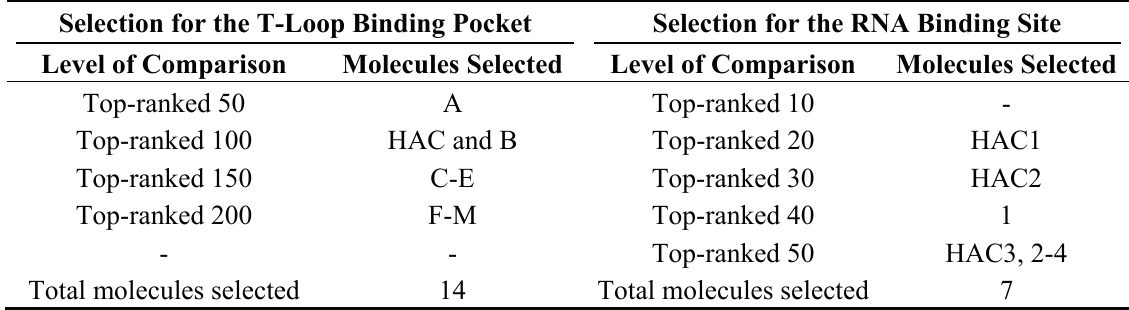
Table 1. Pattern of selection of molecules from the Otava PrimSreen1 diversity library. Selection for the T-Loop Binding Pocket Selection for the RNA Binding